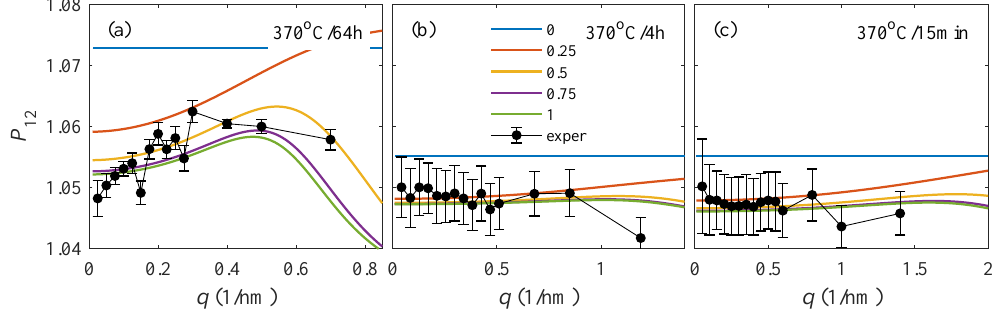
Figure 9. Measured (black dots) and simulated (color lines) q -dependences of the intensity ratio P 12 ( q ) for samples: 370 ◦ C/64 h ( a ); 370 ◦ C/4 h ( b ); and 370 ◦ C/15 min ( c ). The parameter of the simulated curves is the completeness factor p ; see the main text for the simulation